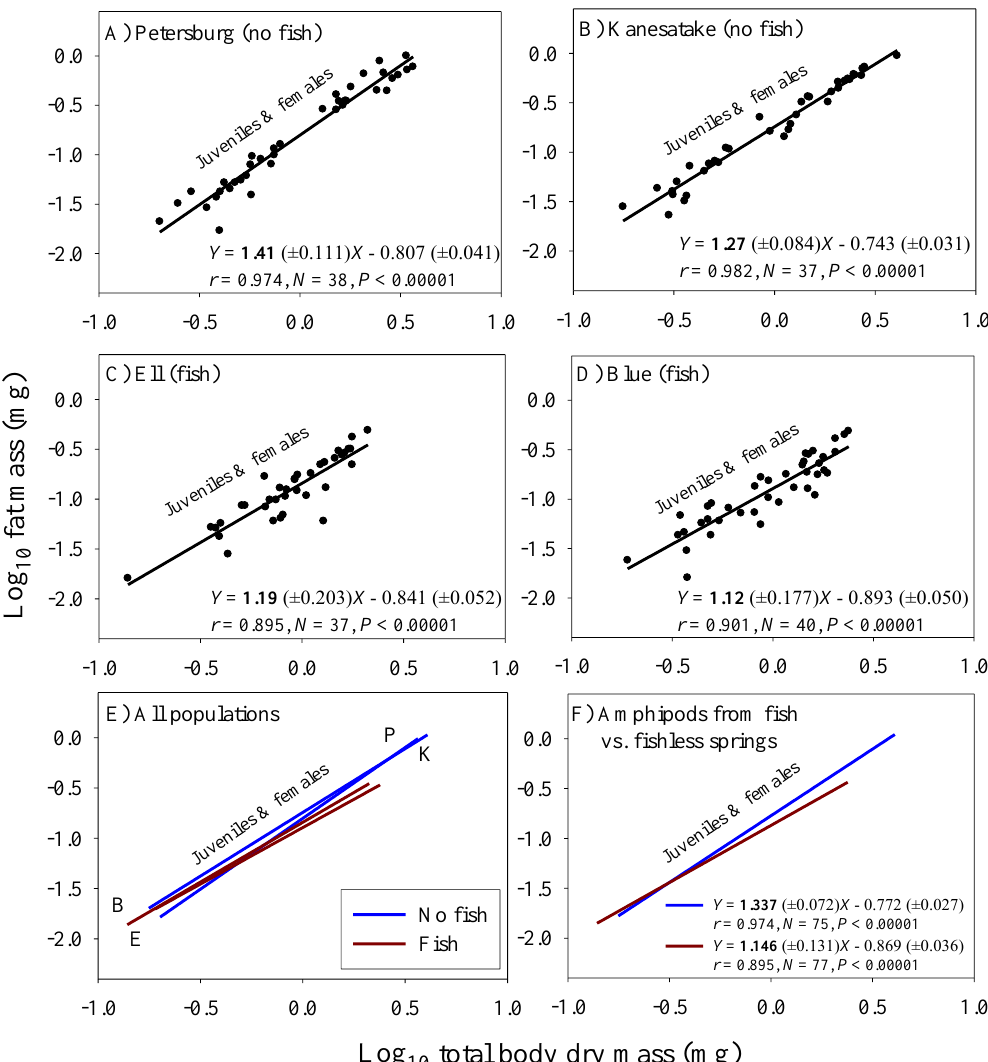
Figure 4. Log 10 fat mass in relation to log 10 dry body mass for juveniles and adult non-brooding females in four populations of the amphipod Gammarus minus . Least squares regression lines and equations are shown (numbers in parentheses are 95% confidence intervals for the intercepts and slopes; r = correlation coe ffi cient; N = sample size; P = probability that the correlation is due to chance). Scaling relationships for two populations in springs without fish predators ( Cottus cognatus ) ( A , B ), for two populations with fish predators ( C , D ), for all four populations compared ( E ), and for the populations with versus without fish, each analyzed collectively ( F